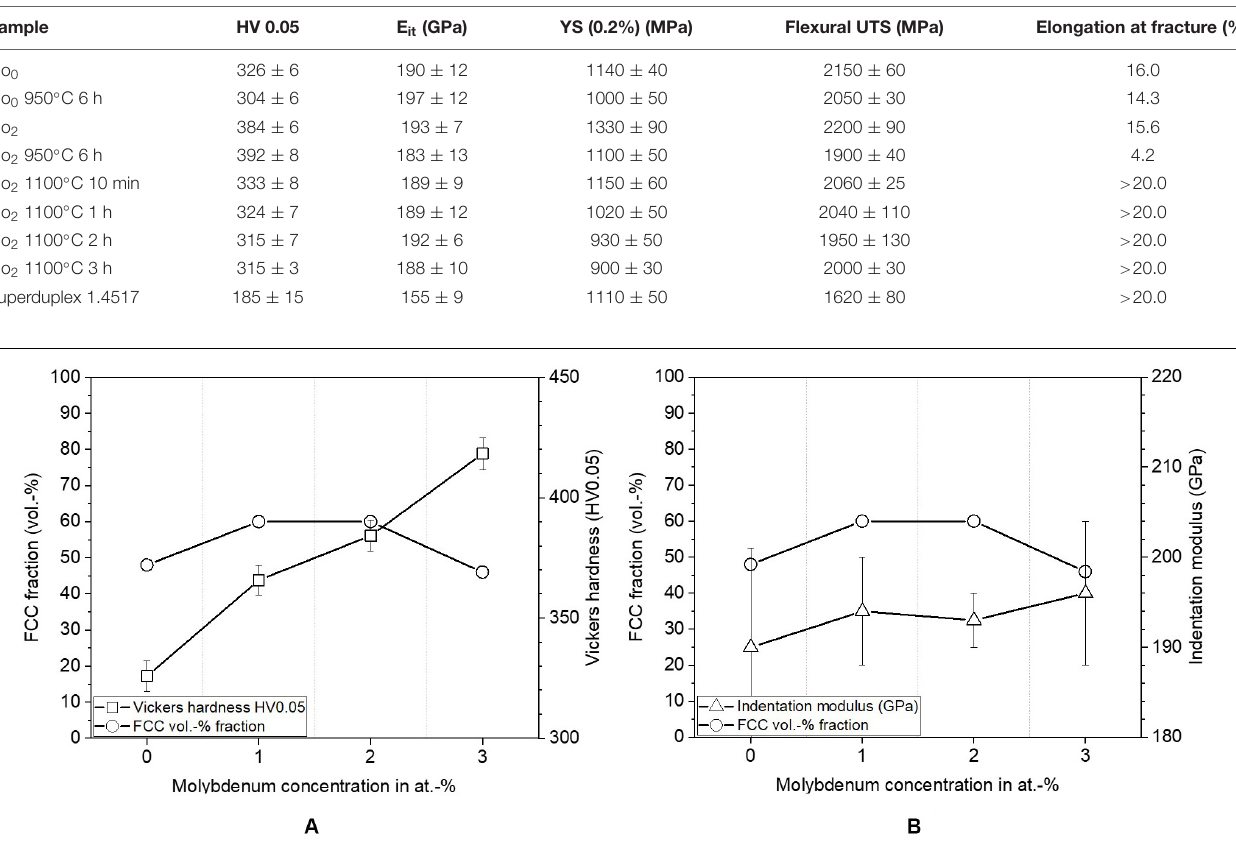
FIGURE 7 | Results from micro-indentation showing (A) the Vickers hardness as function of the molybdenum content, and (B) the indentation modulus (E it ). In both diagrams, the FCC phase fraction is equally